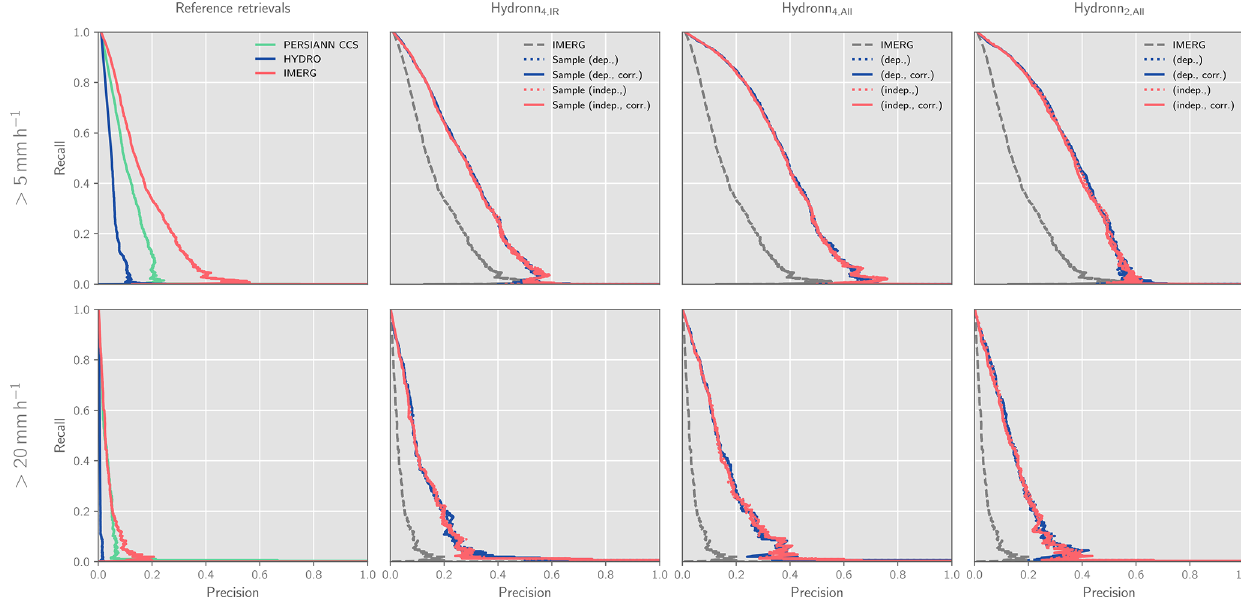
Figure 16. Precision–recall curves for the detection of precipitation events with precipitation rates larger than 5mmh − 1 (first row) and 20mmh − 1 (second row) in December 2020. Columns show the results for the reference retrievals as well as for each of the Hydronn configurations.